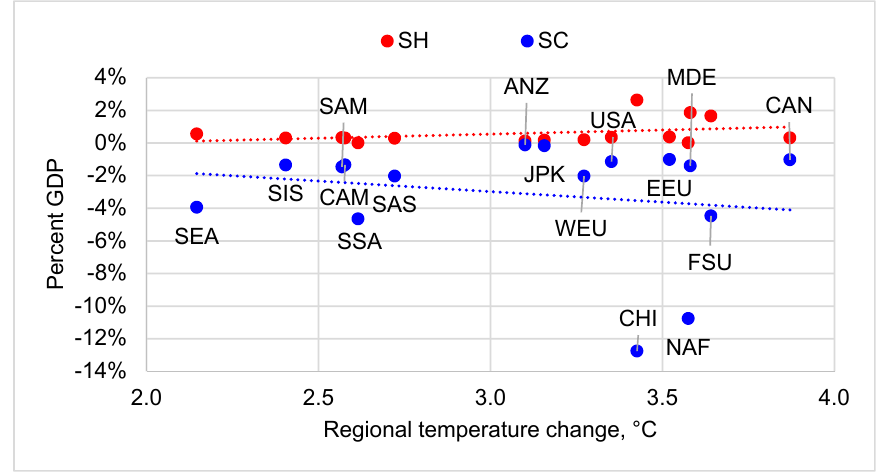
Figure 11. Data points in Figure 10 separated into space heating and space cooling